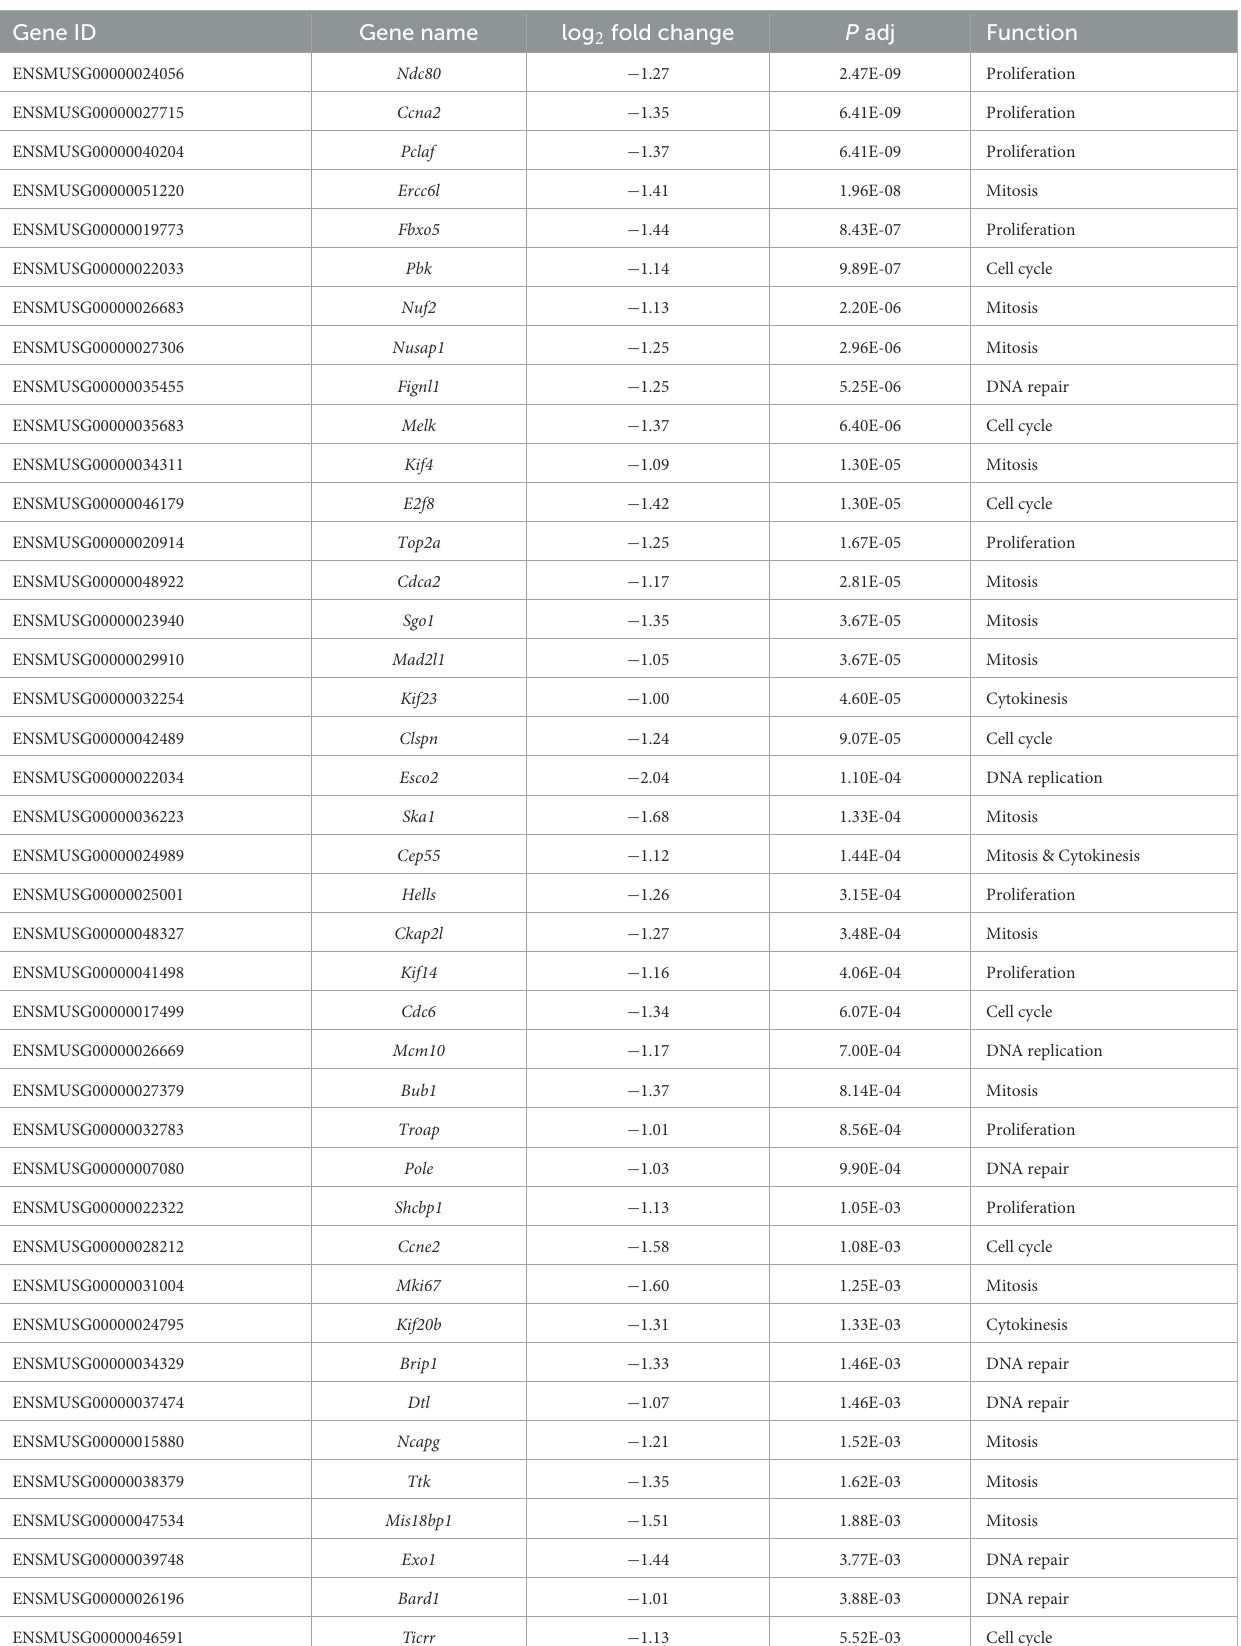
TABLE 7 Significantly downregulated genes in murine astrocytes 24h after exposure to 2Gy